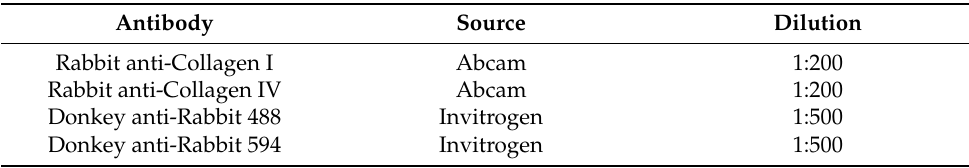
Table 1. Antibody list used for immunocytochemistry